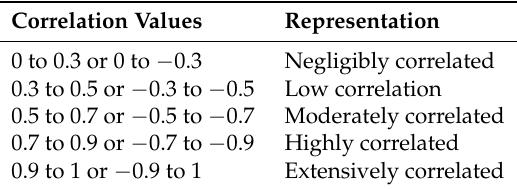
Table 2. Representation of Correlation Values.